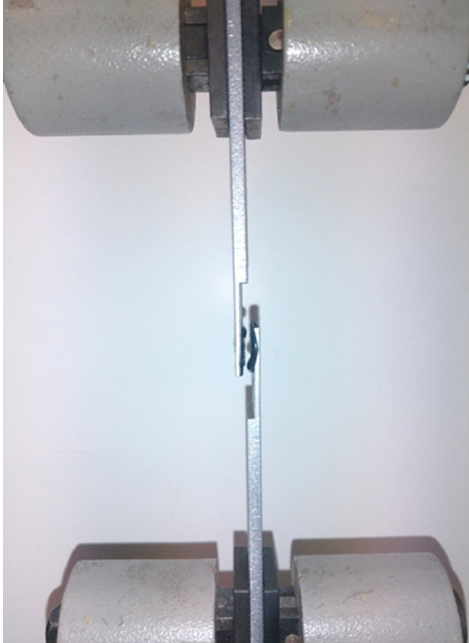
Figure 6. View of the sample after the shear test.